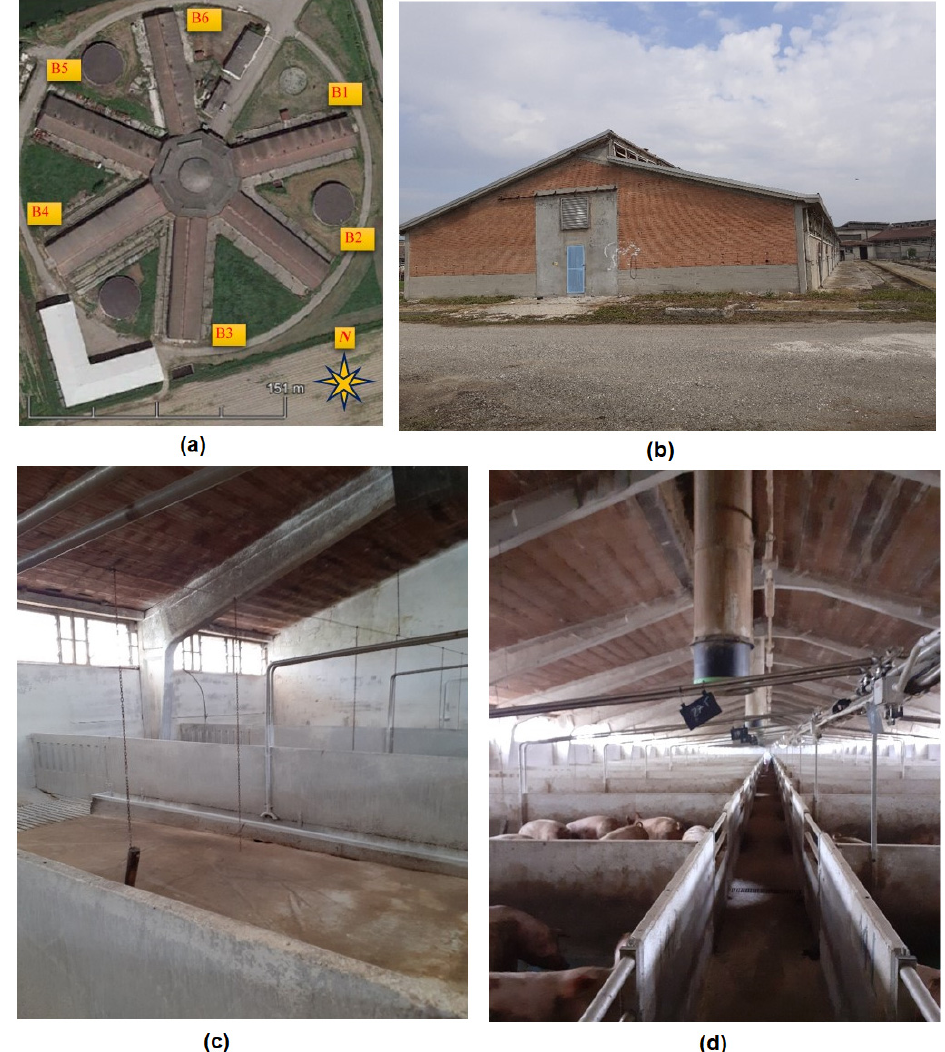
Figure 1. The case study building: ( a ) aerial view of the farm; ( b ) external view of building B3 (naturally ventilated); ( c ) internal view of building B3 (naturally ventilated); ( d ) internal view of the building B5 (mechanically ventilated).